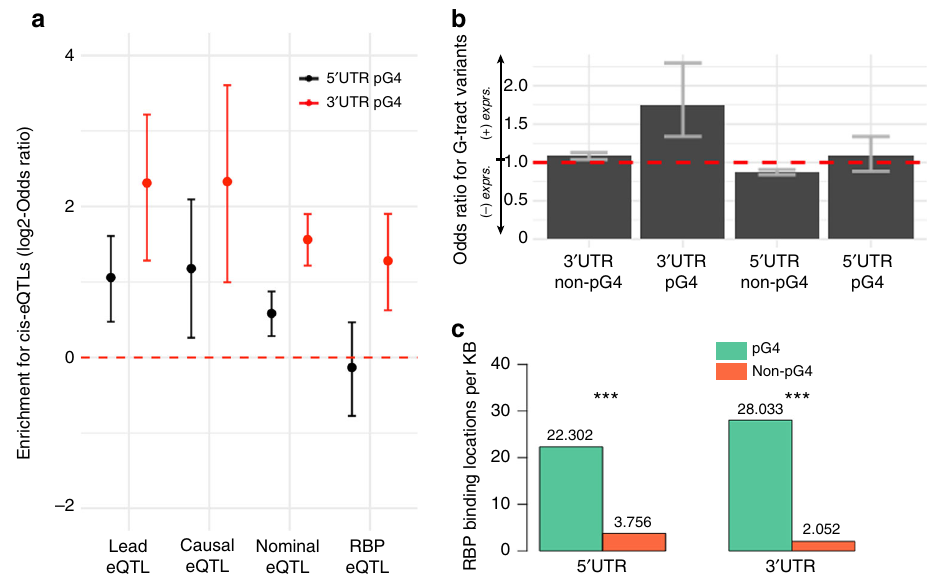
Fig. 3 Enrichment for functional associations within UTR pG4 sequences. a GTEx cis -eQTLs are enriched within UTR pG4 relative to the number of tested (non-eQTL) SNPs when comparing lead SNPs, high-con fi dence causal, nominally signi fi cant, and nominally signi fi cant in RBP-binding sites in matched UTR regions (see Supplementary Table 3 for enrichment statistics) Fisher ’ s exact test. Error bars represent the 95% con fi dence interval for the odds ratio. b Odds ratio for a cis -eQTL increasing gene expression across all cis -eQTL-tissue effects ( n = 379,441, P value < 2e − 16, Fisher ’ s exact test), where the variant affects a pG4 G-tract compared to those affecting gap sequences. Error bars represent the 95% con fi dence interval for the odds ratio. c Density of RBP-binding sites per kilobase of pG4 sequence compared to non-pG4 regions of the UTR ( P value ≪ 2.2 × 10 − 16 , chi-square test). Source data are provided as a Source Data fi